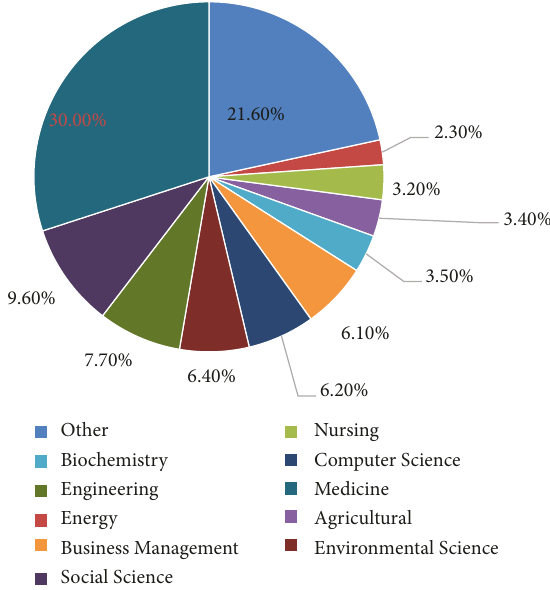
Figure 18: Pie chart depicting article distribution by disciplines for literature review articles.